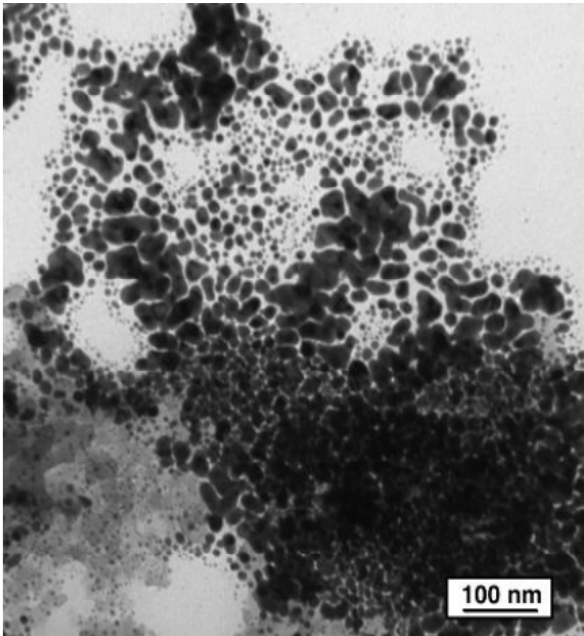
Figure 3. TEM images of Au-DDAB colloid in toluene by the inverse micelle method, before digestive